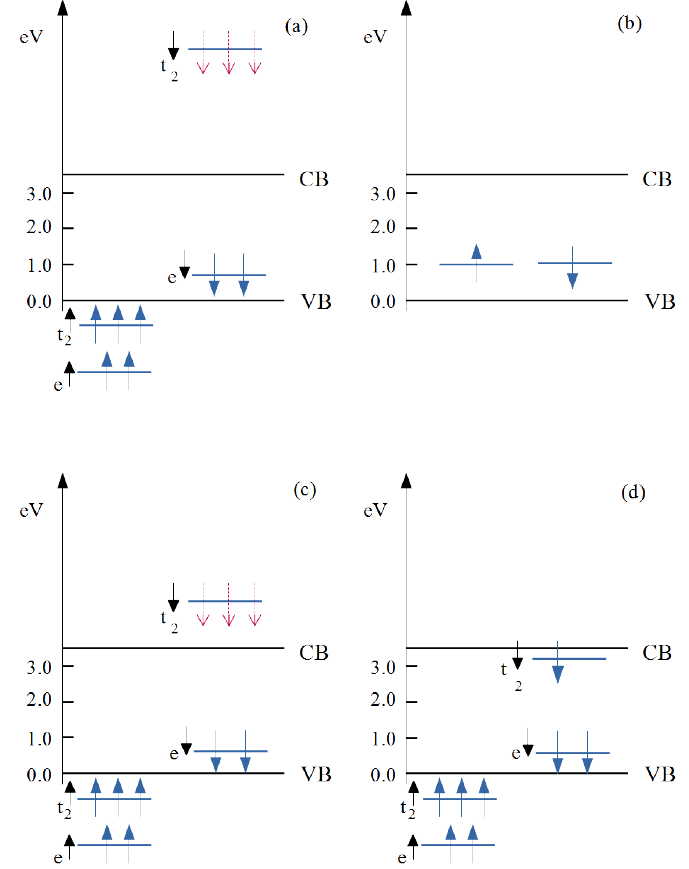
Figure 2. Schematic view of the electronic states induced in the ZnO band gap by: ( a ) a Co atom substituting a Zn one, ( b ) an oxygen vacancy, V O , ( c ) a Co-V O complex, and ( d ) a negatively charged Co-V O − 1 complex. Red–dashed arrows indicate unoccupied, minority spin states. The energy position of the t 2 ↓ states relative to the host conduction band minimum (CBM) is crucial for the ferromagnetism, since it determines the efficacy of a carrier-me- diated mechanism. In fact, generally, the stabilization of the ferromagnetic interaction is related to the electron hopping between transition metal dopant sites hosting partially occupied d states. Such a mechanism is active if the d states are resonant within either the conduction or the valence band continuum of the host semiconductor. In this situation, their occupancy can be continuously varied. Accordingly, theoretical works in the litera- ture [32] indicate that a partial occupancy of the t 2 ↓ states under electron doping is a min- imum requirement for long-range FM interactions between Co ions in ZCO. Such a re- quirement is not satisfied in the case of Co Zn , the t 2 ↓ states being much high relative to the CBM (see Figure 2a). The same theoretical results show a dramatic lowering in the energy of the same t 2 ↓ states when the Co atoms form a Co-V O complex (see Figure 1b for a sketch of the complex structure) from 3.3 eV to 1.3 eV, relative to the CBM (see Figure 2c) [79]. However, the t 2 ↓ states were still too high in energy and the Co-V O complex was no longer considered as a possible cause of FM. On the contrary, a possible role of Co-V O complexes in the appearance of RT-FM was investigated in a further study where Co K-edge XANES (X-ray absorption near-edge structure) and RT magnetization versus field (H) measure- ments were performed together with theoretical calculations [73]. Three Zn 1-x Co x O epi-